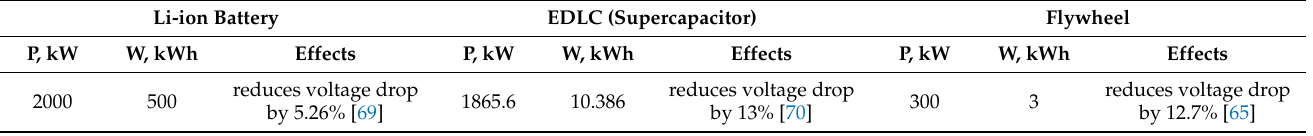
Figure 2. Power rating and energy capacity of different stationary (wayside) ESSs for electrified railway systems (data based on references [56,59,60]). Table 4. Examples of ESS using for voltage